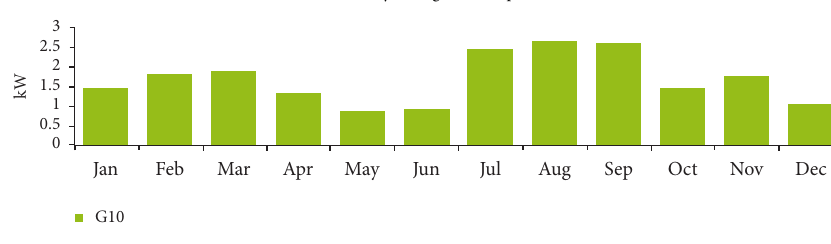
Figure 11: Monthly average electric production by HRES 2. Table 5: Technical comparison of HRES